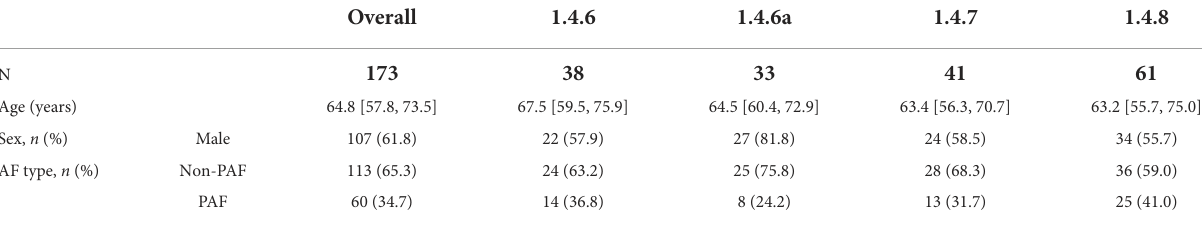
TABLE 1 Baseline patient